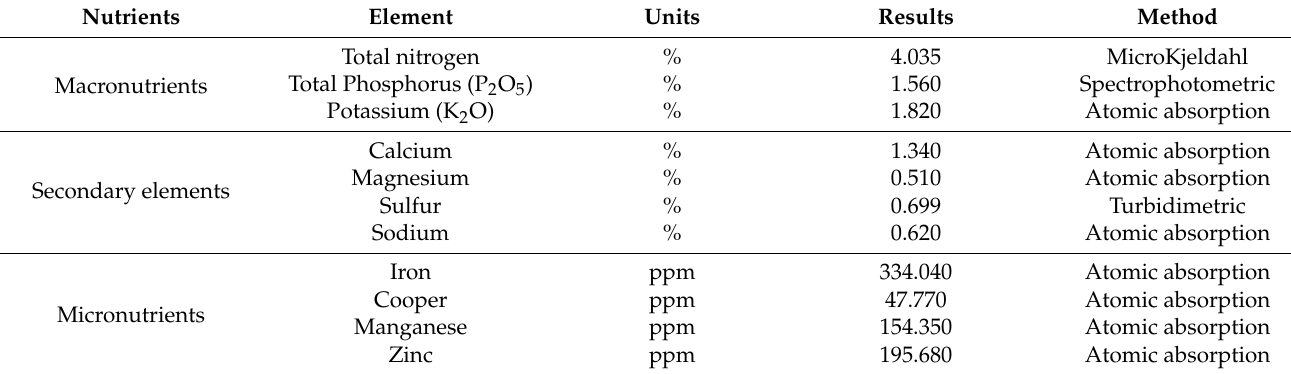
Table 2. Nutrient analysis of the cricket frass used in the study.